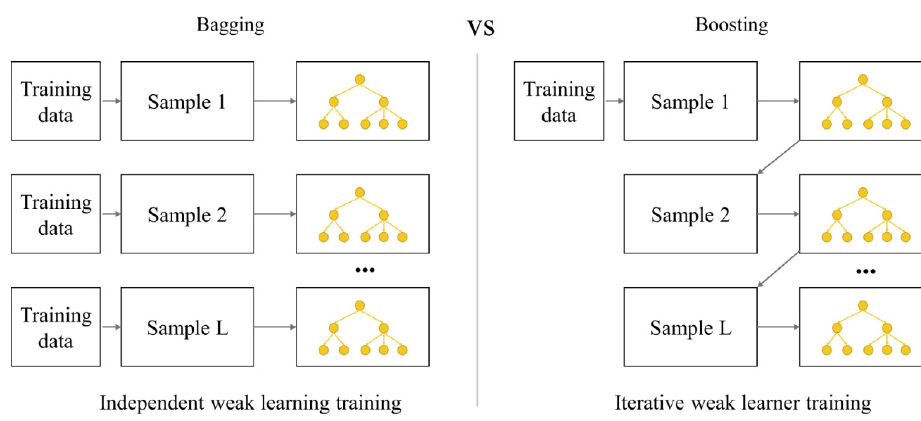
Figure 1. Workflows of bagging and boosting